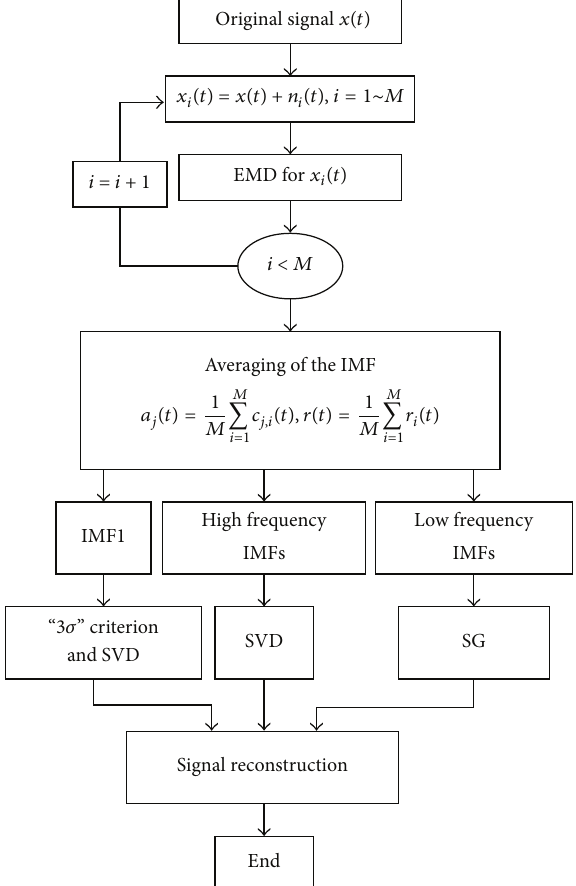
Figure 2: The flow chart of improved